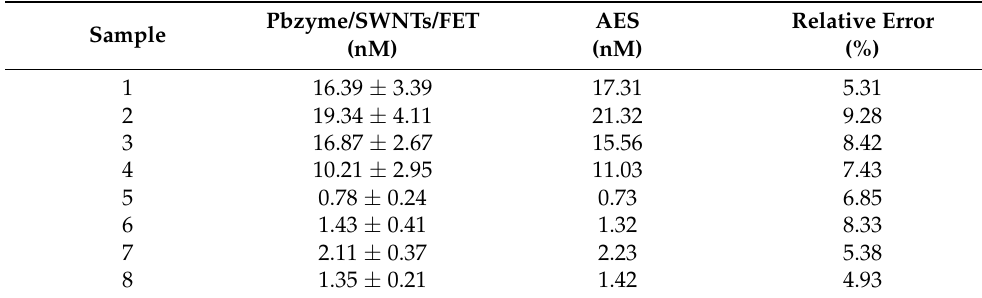
Table 3. Pb 2+ analysis of Pbzyme/SWCNTs/FET in woodland soil and paint samples. Reprinted with permission from reference [121]. Copyright 2019 John Wiley and